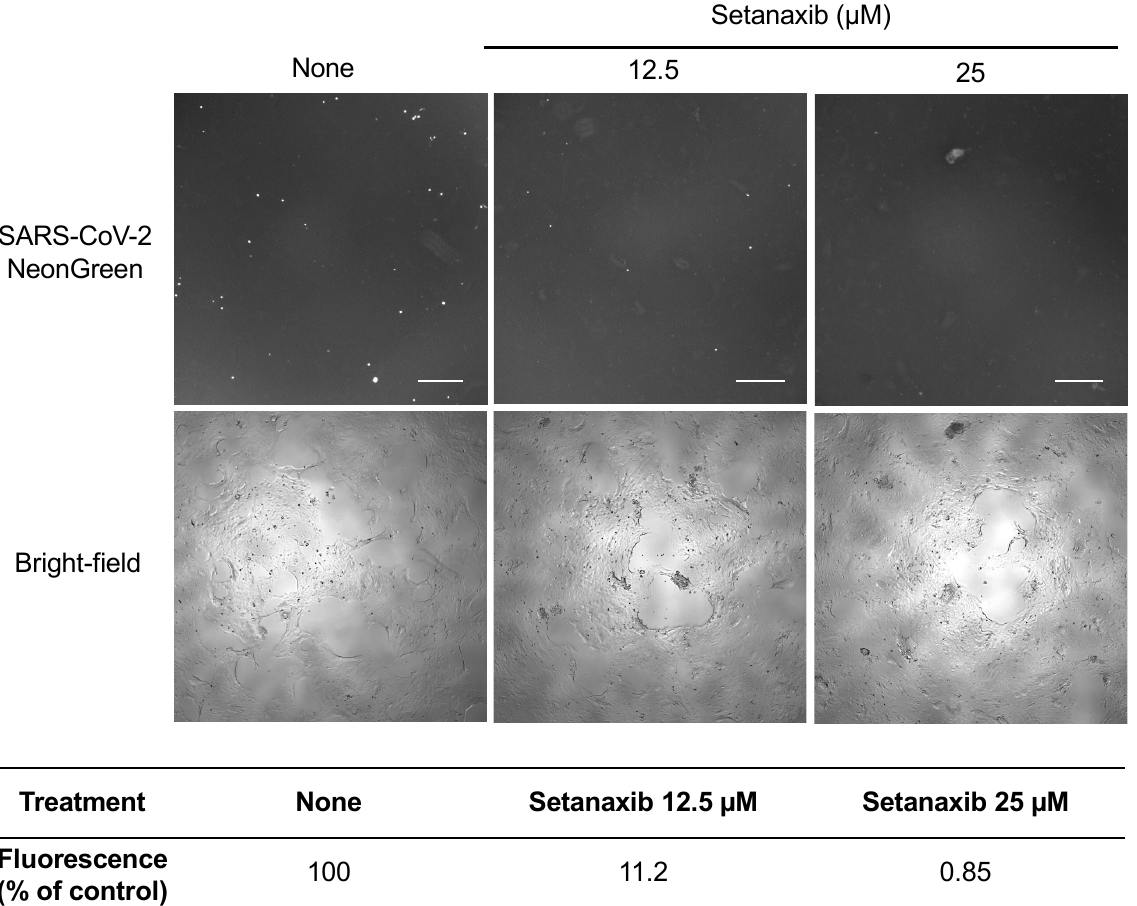
Figure 6. Setanaxib is inhibiting SARS-CoV-2 infection in human primary nasal epithelial cells. Primary nasal epithelial cells from healthy donors were infected with SARS-CoV-2 expressing mNeonGreen (MOI = 0.7) and cultured without or with Setanaxib at 12.5 or 25 µ M. After 24 h, infection was determined by fluorescence microscopy for mNeonGreen expression. Scale bar is 300 µ m. Fluorescence signal from culture wells was determined with ImageJ. Results are expressed as percentage of the untreated control